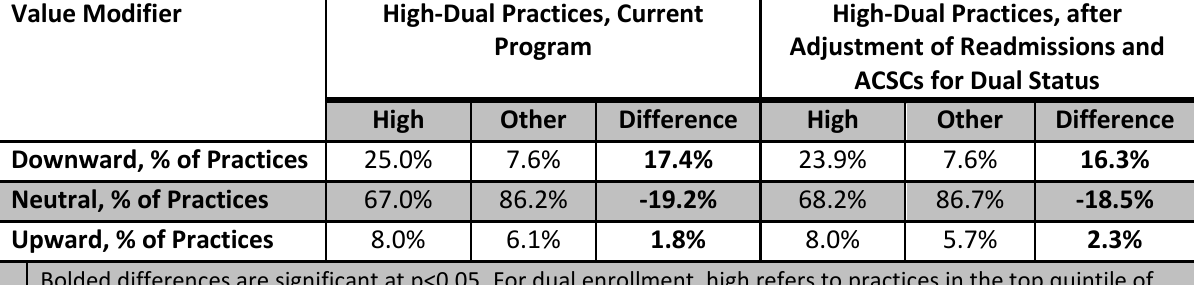
Table 10.17. Impact on High-Dual Practices of Adjusting Mandatory VM Quality Measures for Dual Enrollment